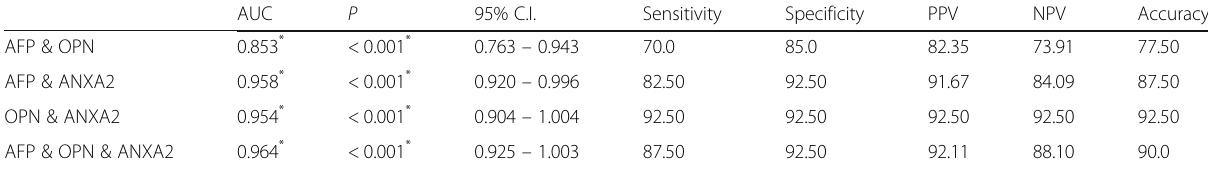
Table 4 Agreement (sensitivity, specificity) for combination of different tumor markers to diagnose HCC AUC P 95% C.I.